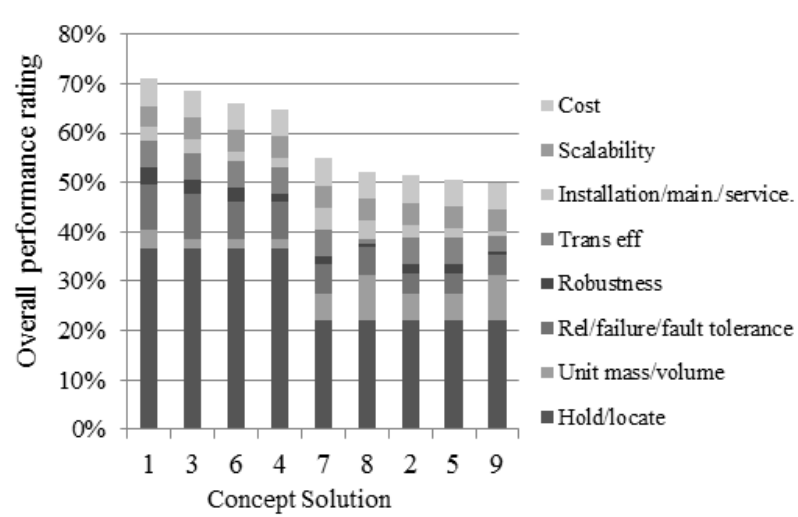
Figure 3. Overall weighted performance criteria.